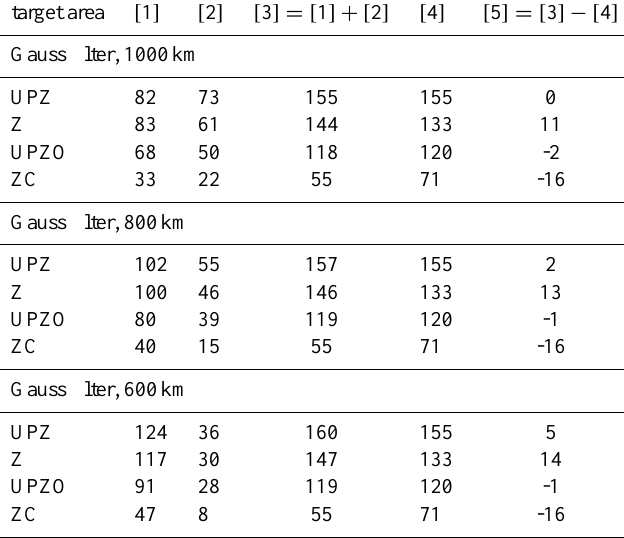
Table 2. Amplitude of the annual water storage variation. [ 1 ] : GRACE estimate, [ 2 ] : annual bias, [ 3 ] : bias-corrected GRACE, [ 4 ] : LEW model output, [ 5 ] : difference between bias-corrected GRACE and LEW model output.